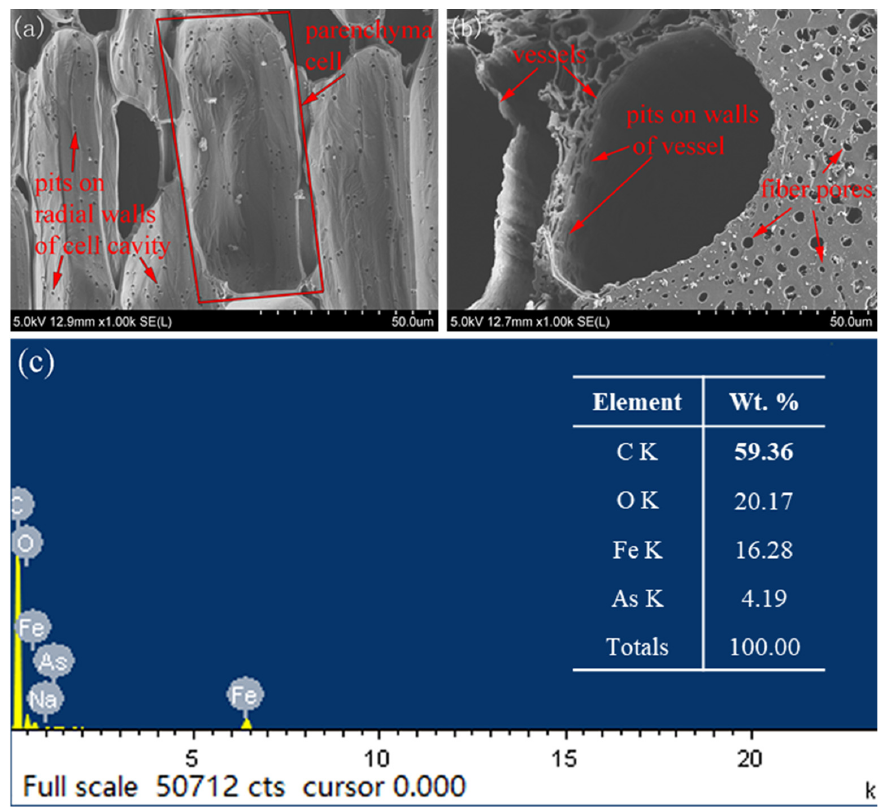
Figure 1. SEM images of PC ‐ Fe/C ‐ B, after As(V) adsorption: ( a ) transverse section. ( b ) longitudinal section and ( c ) EDS spectrum of PC ‐ Fe/C ‐ B, after As(V) adsorption.